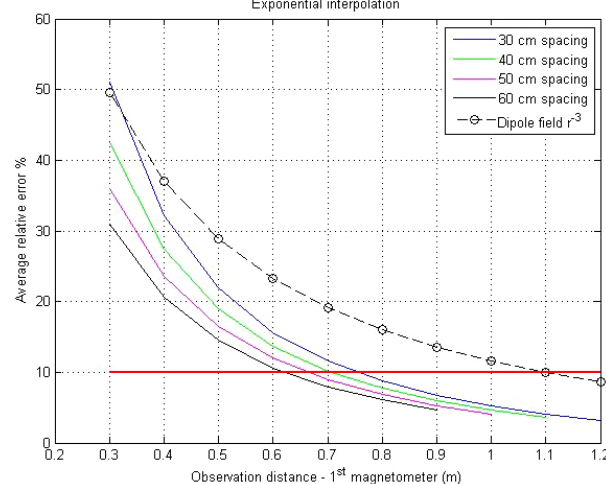
Figure 3. Magnetic field’s relative error with respect to the first magnetometer’s position with fixed spacing 30cm between the magnetometers – 12 independent trials.